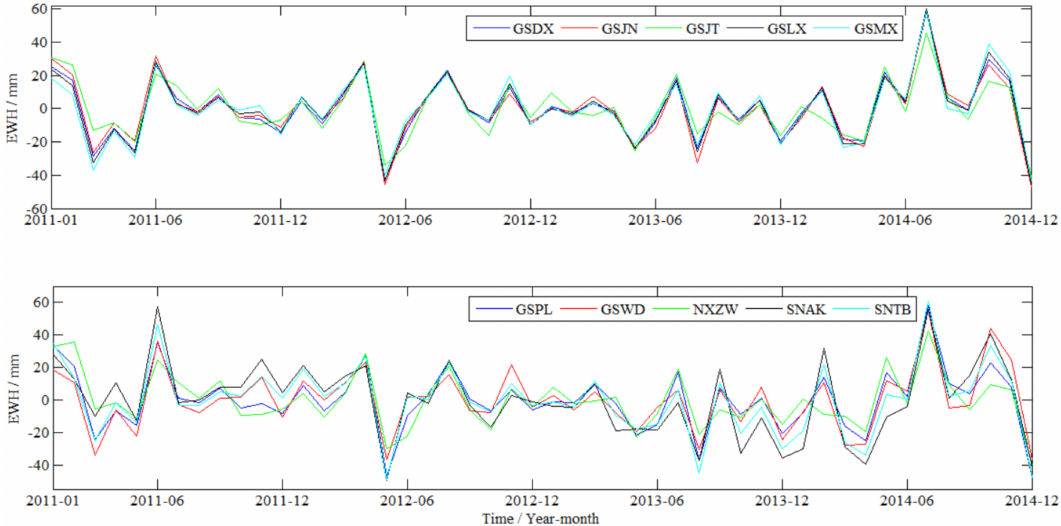
Figure 11. Time series of GWS changes at CORS stations derived from